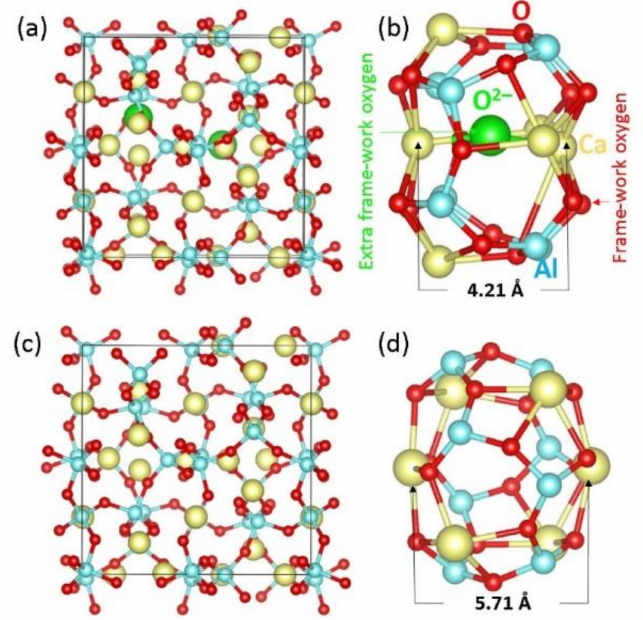
Figure 1. Optimised structures of ( a ) the crystal structure of C12A7:O 2 − , ( b ) the cage occupying extra-framework O 2 − ion, ( c ) the crystal structure of C12A7:e − and ( d ) the cage occupying extra-framework e − . Cage pole, Ca-Ca distances are calculated to be 4.21 Å and 5.71 Å in C12A7:O 2 − and C12A7:e − ,